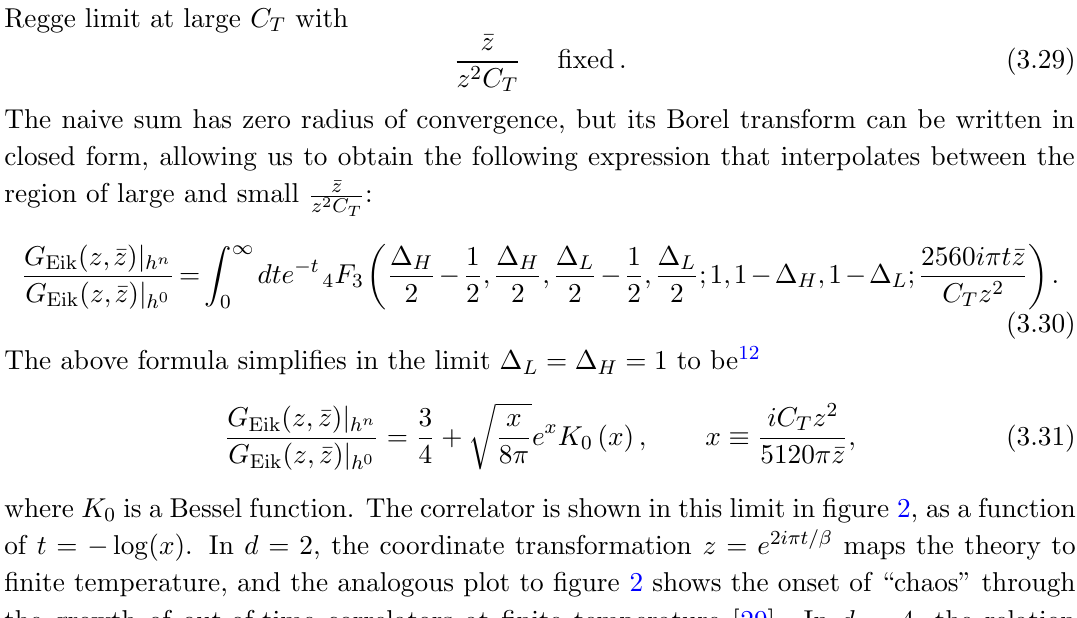
+ p x e x K 0 ( x ) j 4 8 (cid:25)